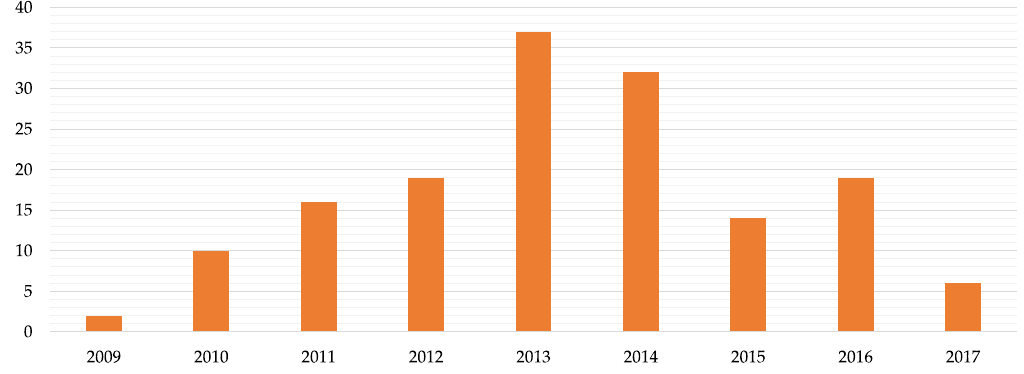
Figure 2. Number of judgements introduced per